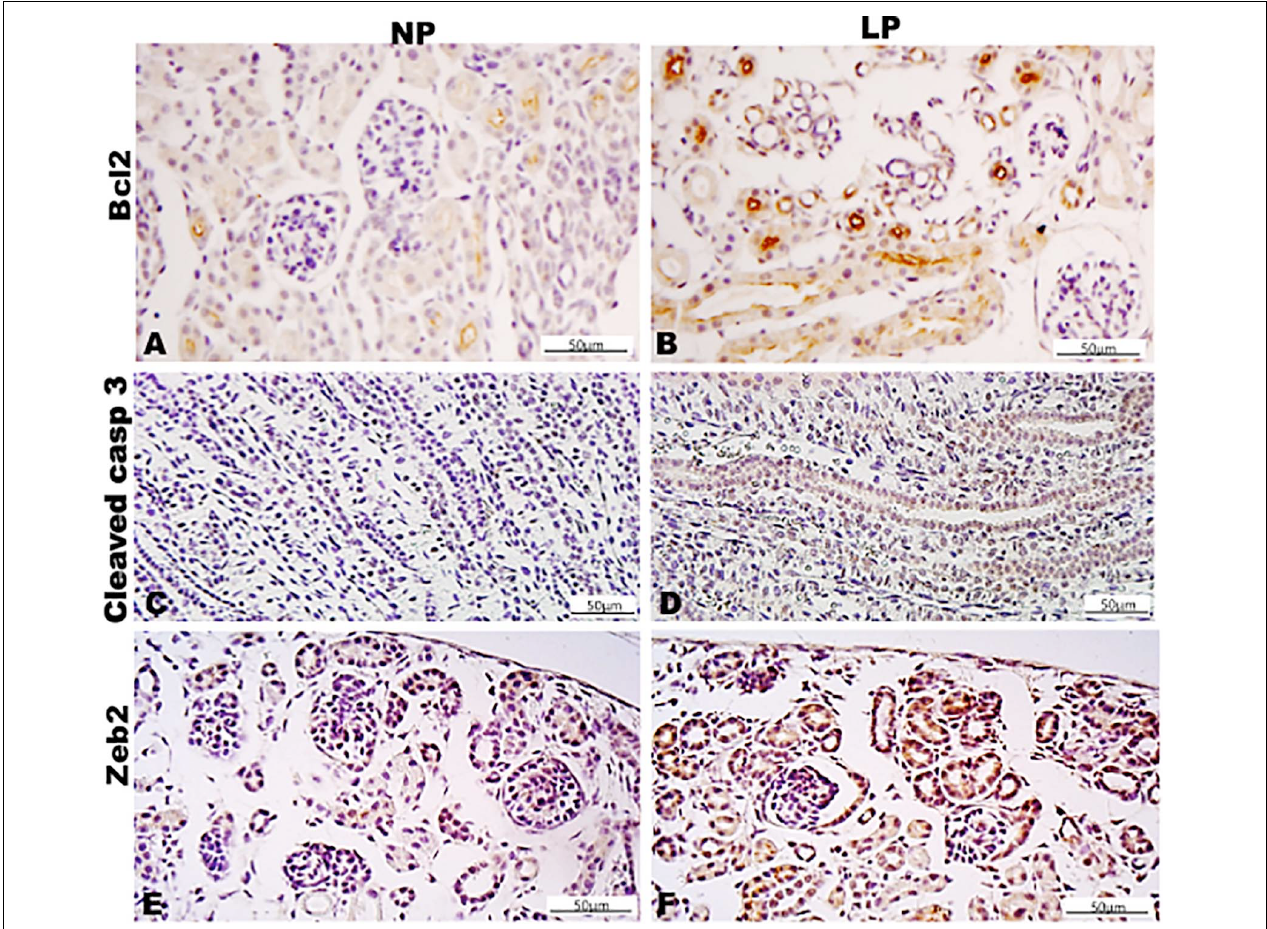
FIGURE 11 | Immunoperoxidase in kidneys of 7DL rats for (A,B) Bcl2, (C,D) cleaved casp 3, and (E,F) Zeb2 for the NP (A,C,E) and LP (B,D,F)